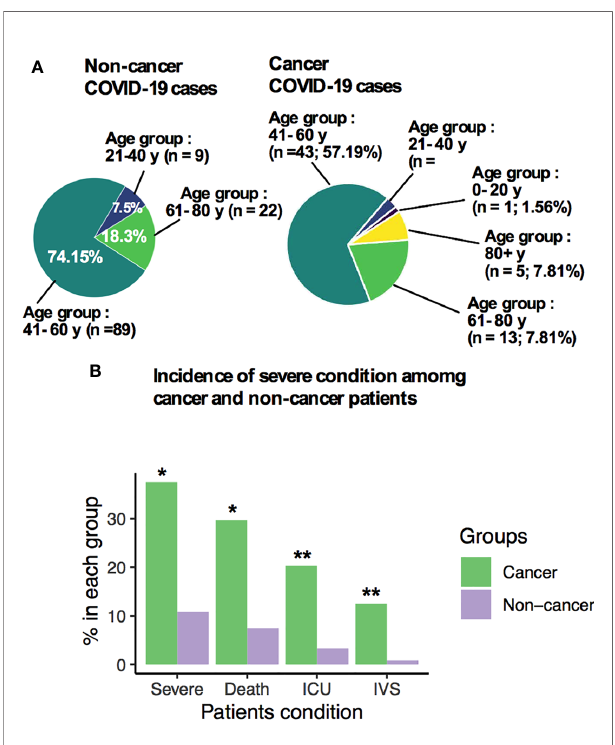
FIGURE 1 | Clinical characteristics of patients among non-cancer and cancer patients. (A) Age distribution of patients with non-cancer and cancer patients. (B) Incidence of severe condition among non-cancer and cancer patients. *P ≤ 0.05; **P ≤ 0.01.